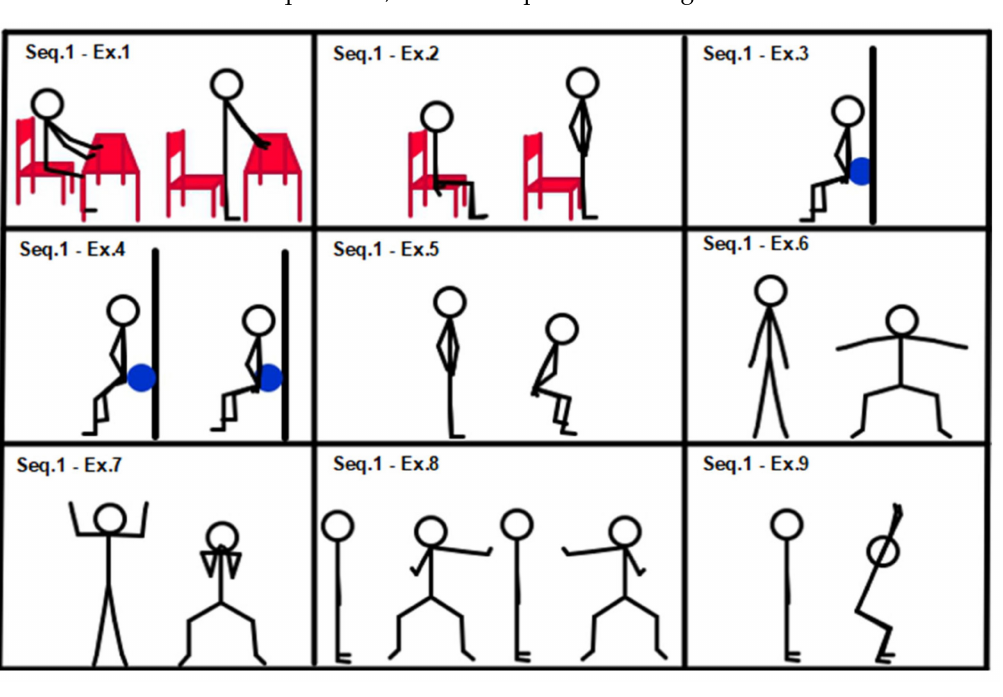
Figure 1. Sequence 1: lower limbs, entry level.